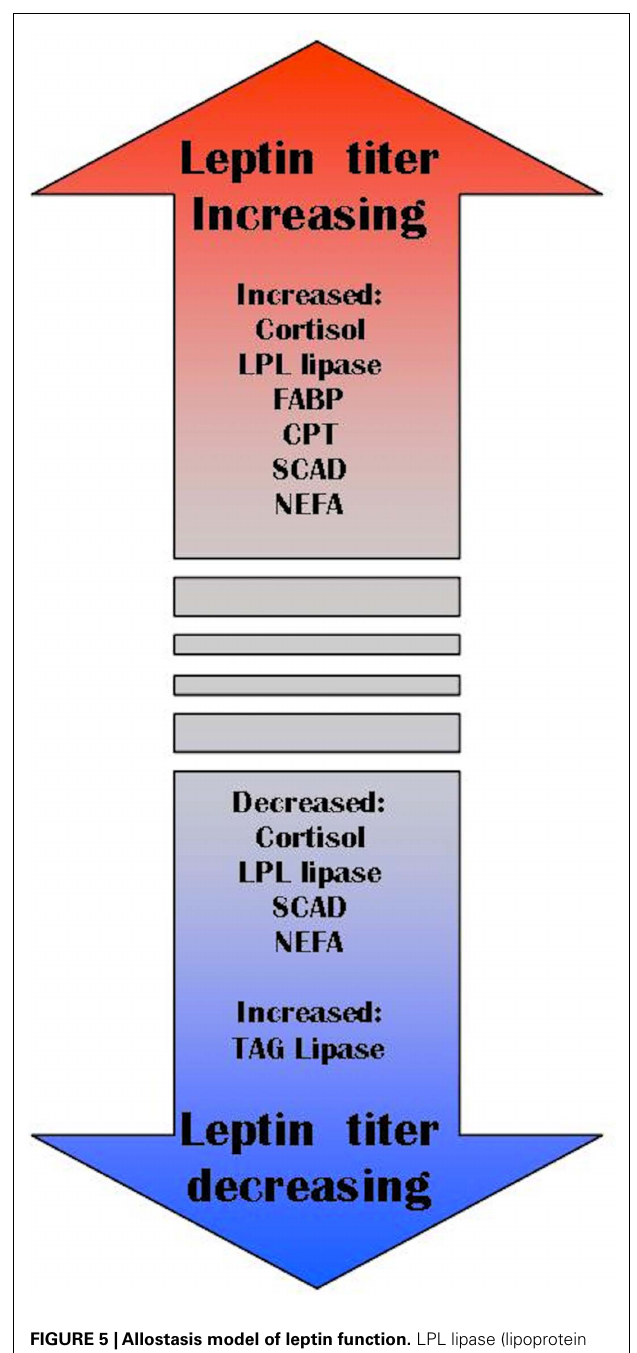
FIGURE 5 |Allostasis model of leptin function. LPL lipase (lipoprotein lipase), FABP (fatty acid-binding protein), CPT (carnitine palmitoyl transferase), SCAD (stearoyl CoA desaturase-1), NEFA (non-esterified fatty acids),TAG lipase (triacylglycerol lipase).